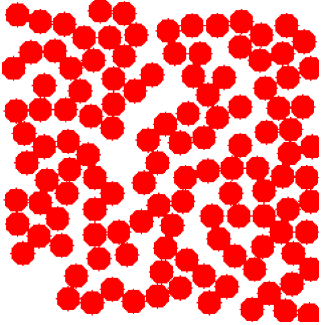
Figure 7. Cross-section of generated structure 13.